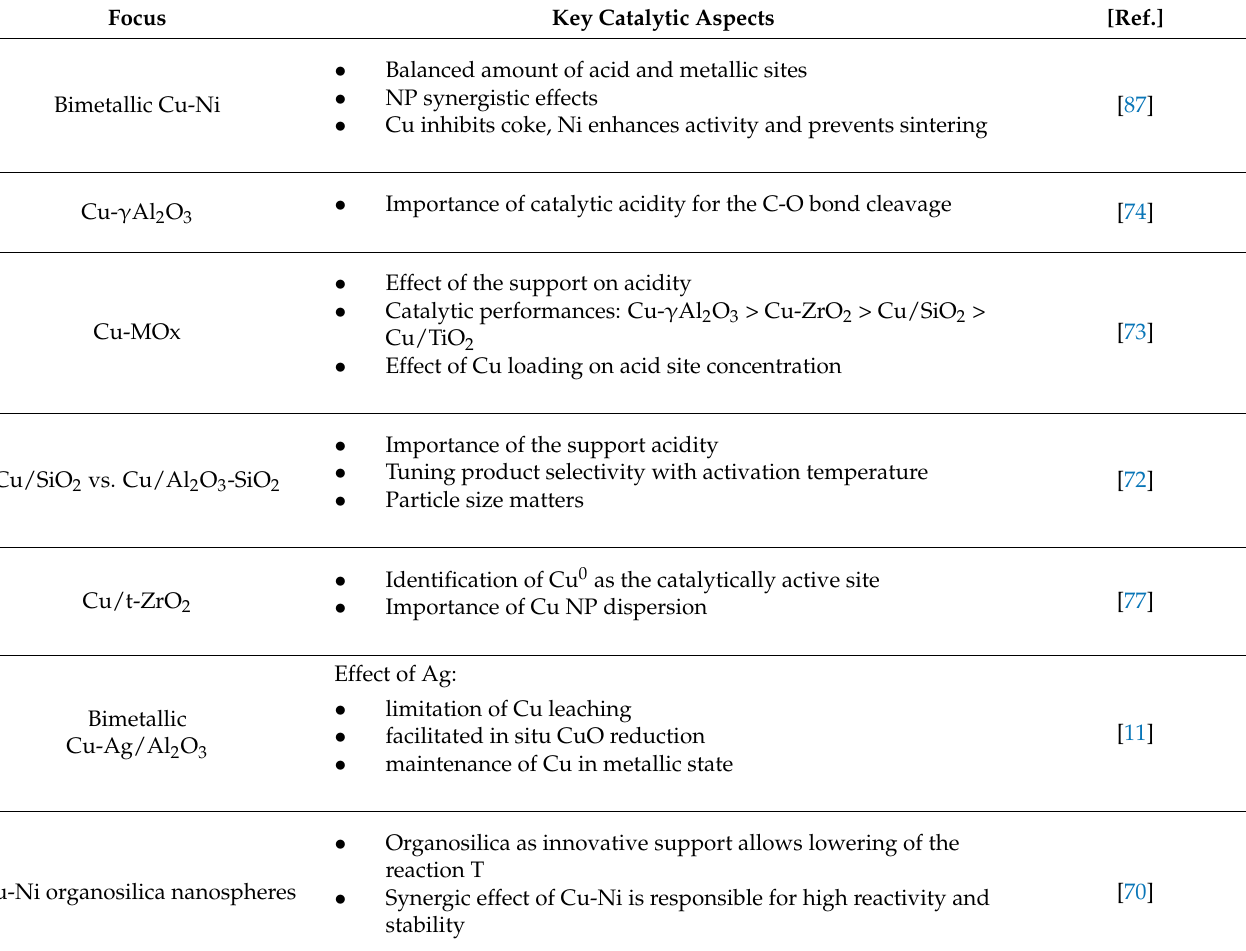
Table 3. Selected key catalytic aspects of the comprehension of Cu and bimetallic